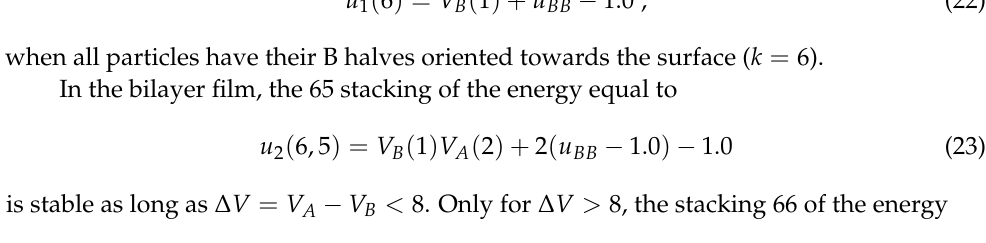
Figure 4. The ground state phase diagrams for the systems with V o = − 0.9 ( a panel) and − 1.0 ( b panel). The numbers mark regions of different film thickness. Only the regions with u BB close to − 1.0 are